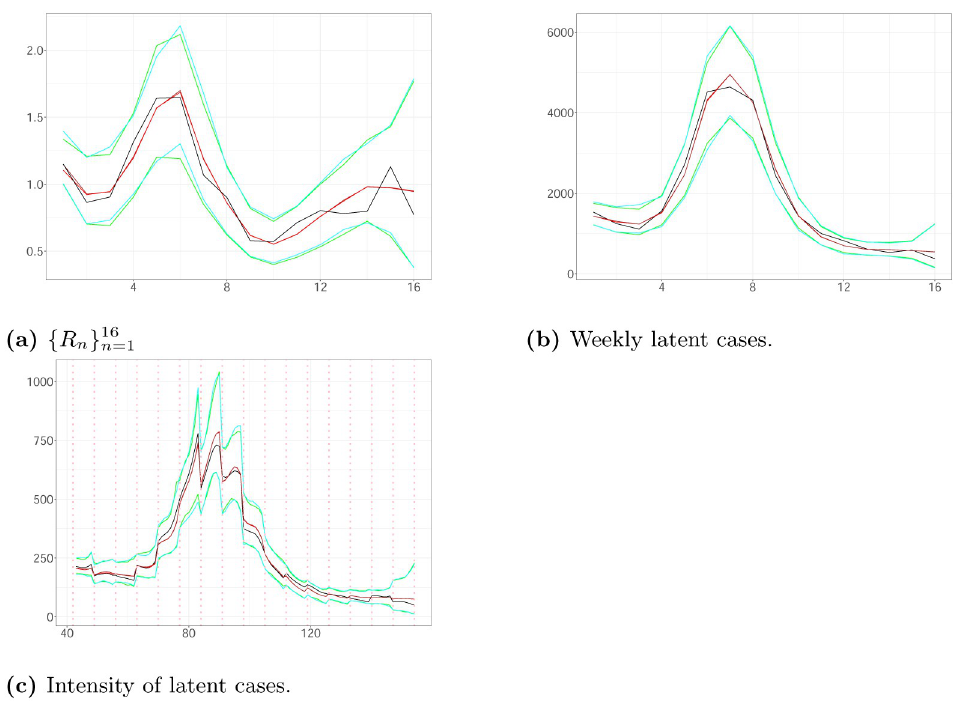
Fig 4. The true (black line) and the estimated weighs f R g 16 , weekly latent cases and latent intensity (with n n ¼ 1 estimated seeds (posterior median (brown line); 99% CI (cyan line)), and true seeds (posterior median (red line); 99% CI (green line))) in Scenario B plotted against time. The vertical dotted lines show the beginning of each week in the period we examine. (a) f R g 16 . (b) Weekly latent cases. (c) Intensity of latent cases. n n ¼ 1